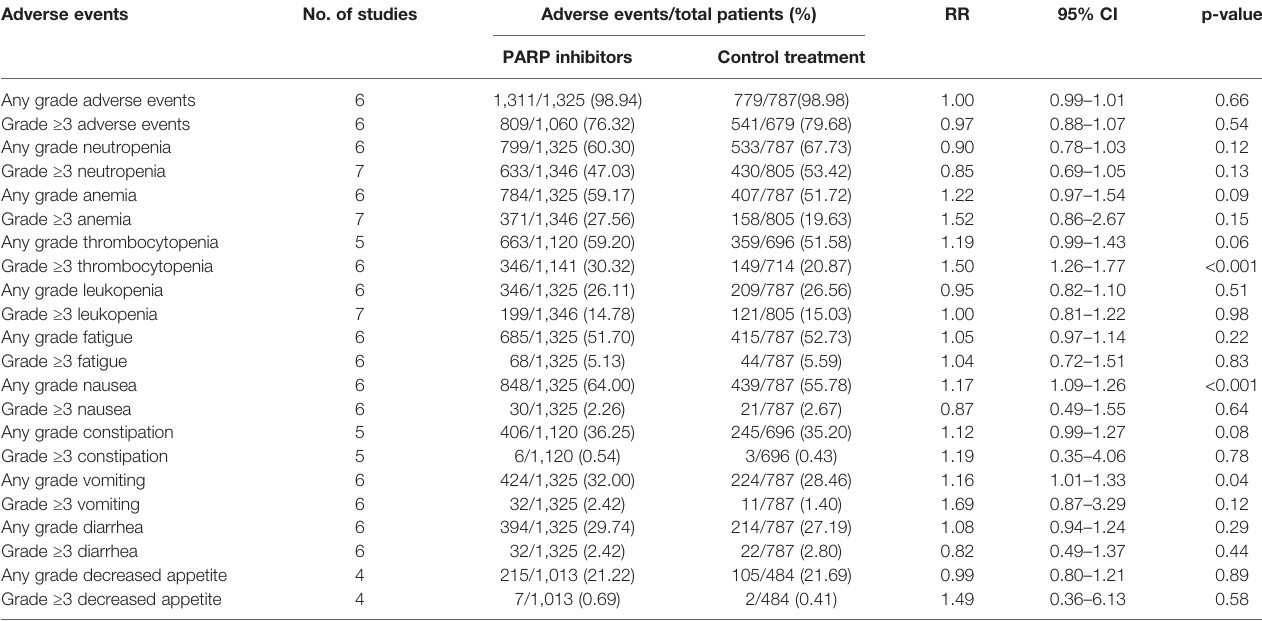
TABLE 2 | Summary of the adverse events (AEs). Adverse events No. of